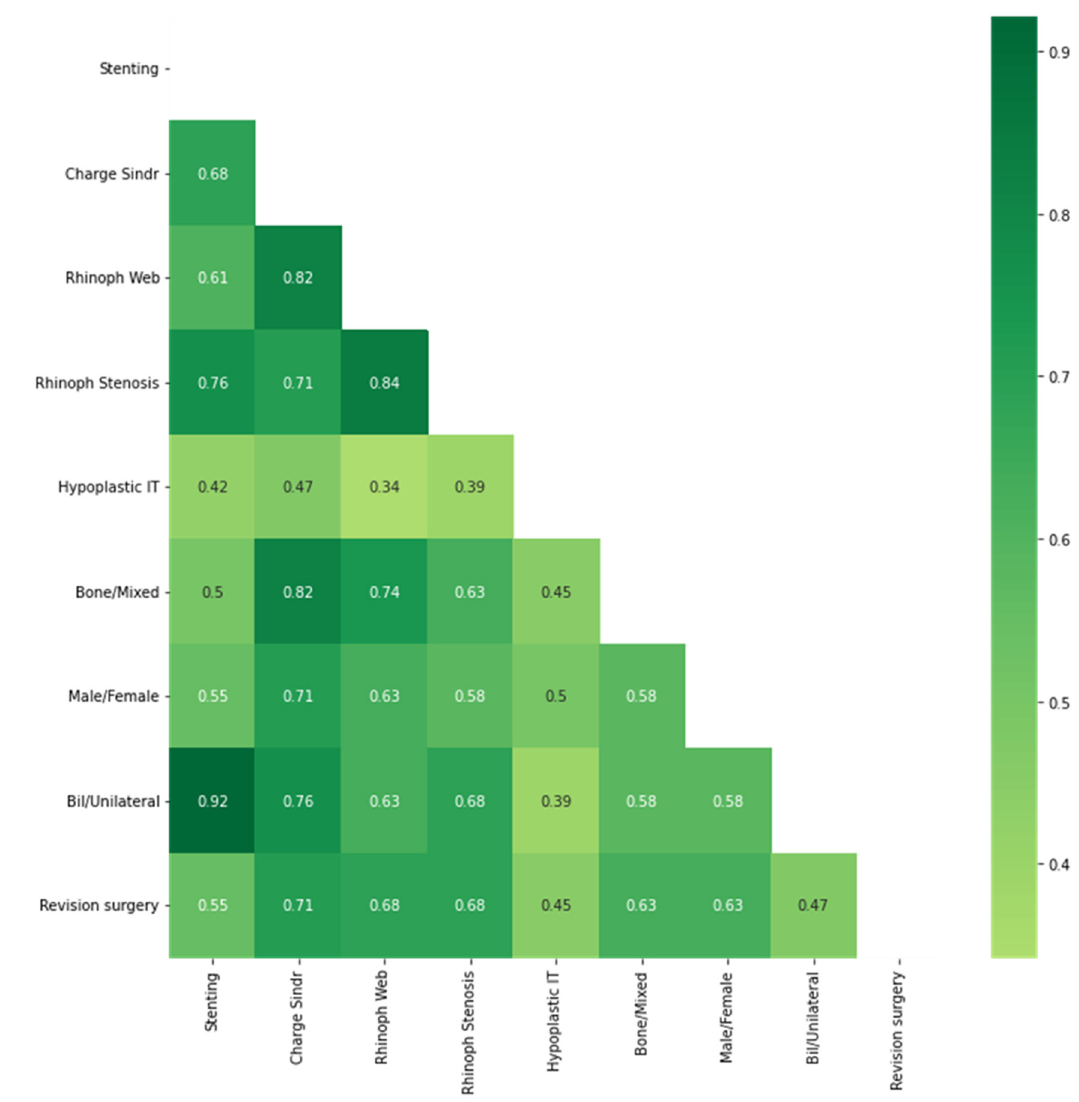
Figure 4. Heatmap of Jaccard similarity coefficients matrix.